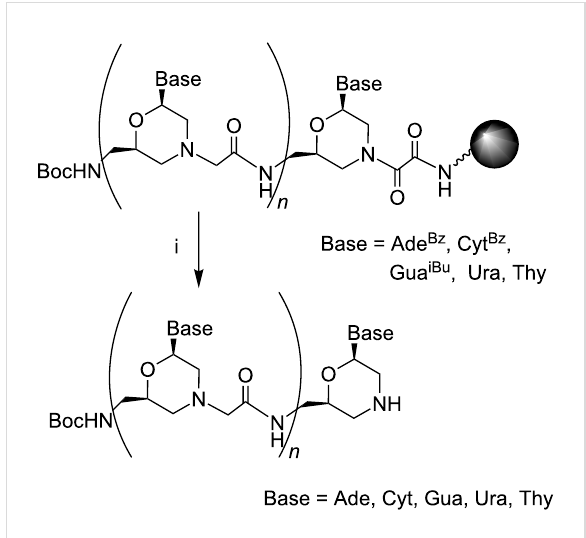
Figure 3: Cleavage of MorGly oligonucleotide mimics from solid support and deprotection of nucleobases by aqueous ammonia treat- ment: i) NH 3 /H 2